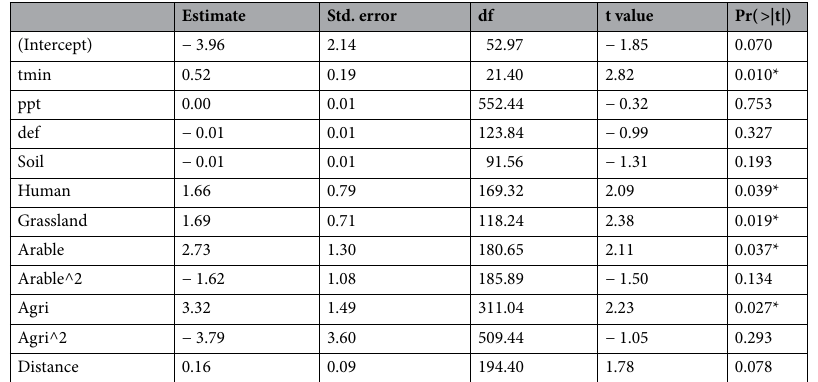
Table 1. The linear mixed effect model with restricted maximum-likelihood describing the relationship between breeding effect of white storks with land cover, weather conditions, and distance to the nearest landfill. tmin average minimum temperature during breeding season, ppt average accumulated monthly precipitation during breeding season, def average climatic water deficit during breeding season, soil moisture average soil moisture at the end of each month during breeding season, human cover of highly human changed areas, grassland cover of pastures and meadows, arable cover of non-irrigated arable lands, agri cover of other agricultural lands, distance ln distance to the nearest landfill. *p <